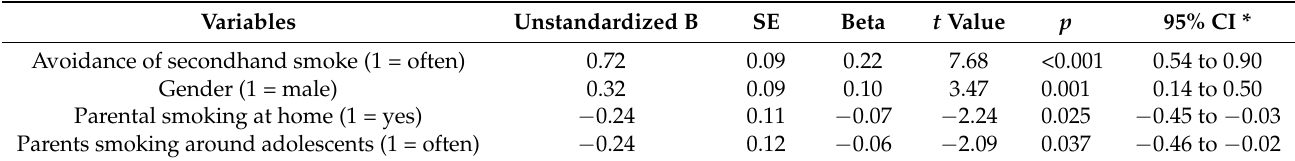
Table 3. Determinant factors associated with adolescent’s health-promoting behaviors ( n =